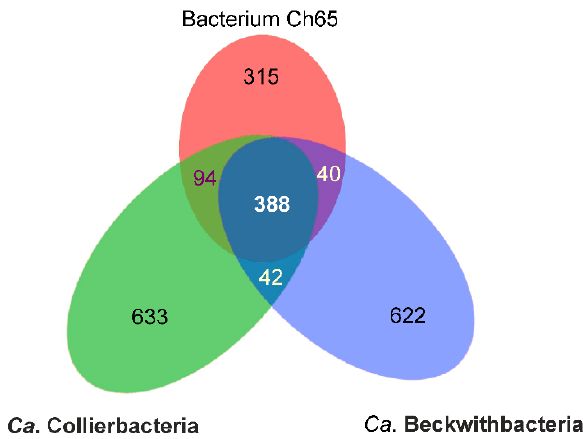
Figure 2. Homologous protein ‐ coding genes of Ch65 bacterium, Candidatus Collierbacteria bacterium RIFOXYD2_FULL_45_13 and Candidatus Beckwithbacteria bacterium GW2011_GWC1_49_16. Genes were considered present in a pair of genomes if the region of similarity covered >80% of the shorter corresponding protein, with BlastP e ‐ value < 1 × 10 − 10 .